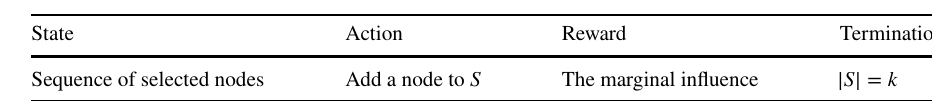
State Action Reward Sequence of selected